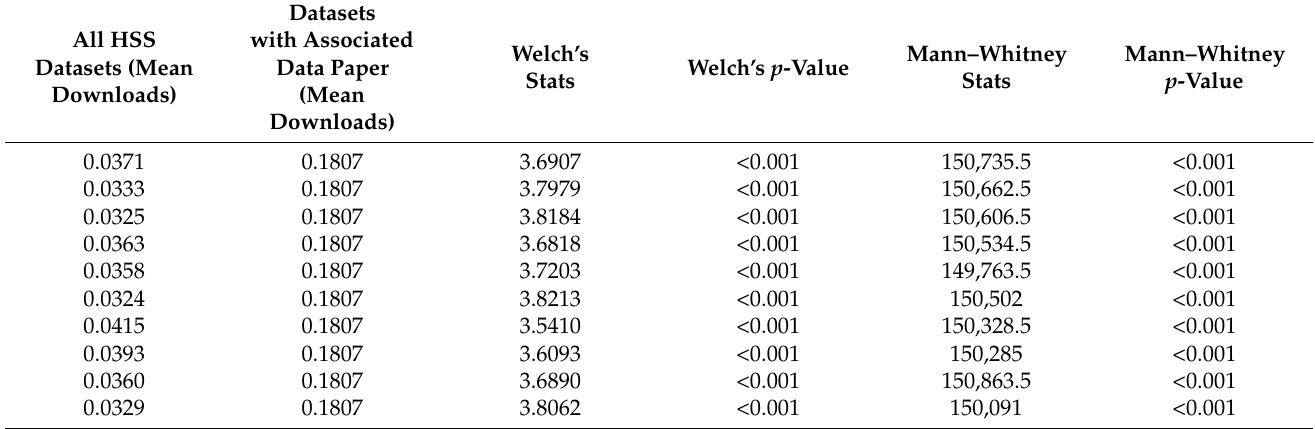
Table 8. Welch’s t -test and Mann–Whitney U -test results: mean downloads of datasets with an associated